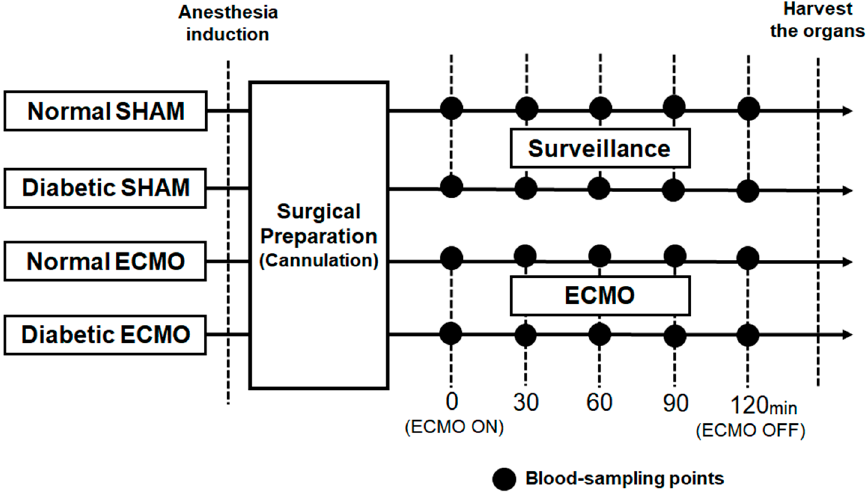
Figure 2. Schematic diagram of experimental design.